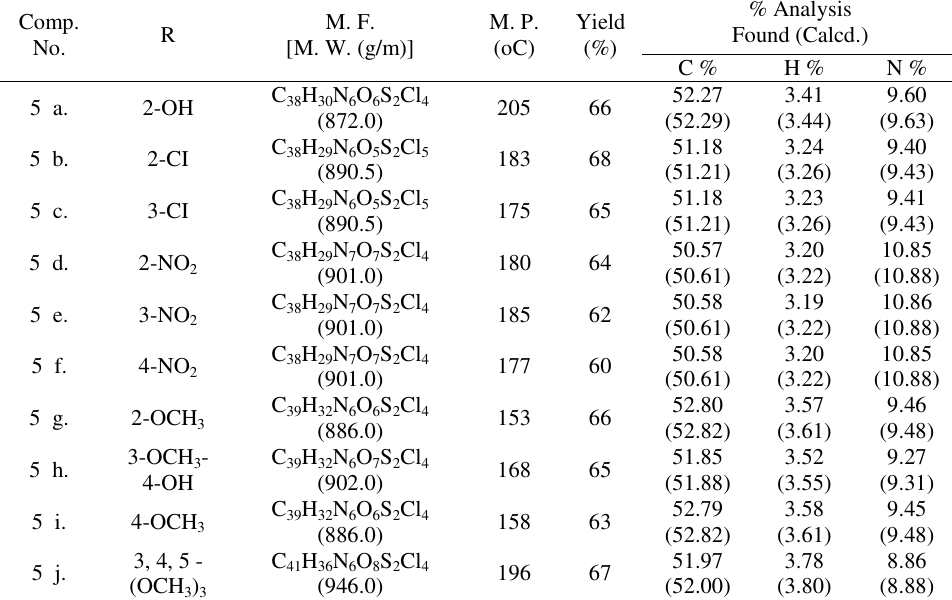
Table 5 . PHYSICAL AND ANALYTICAL DATA OF COMPOUNDS [5(a-j)]